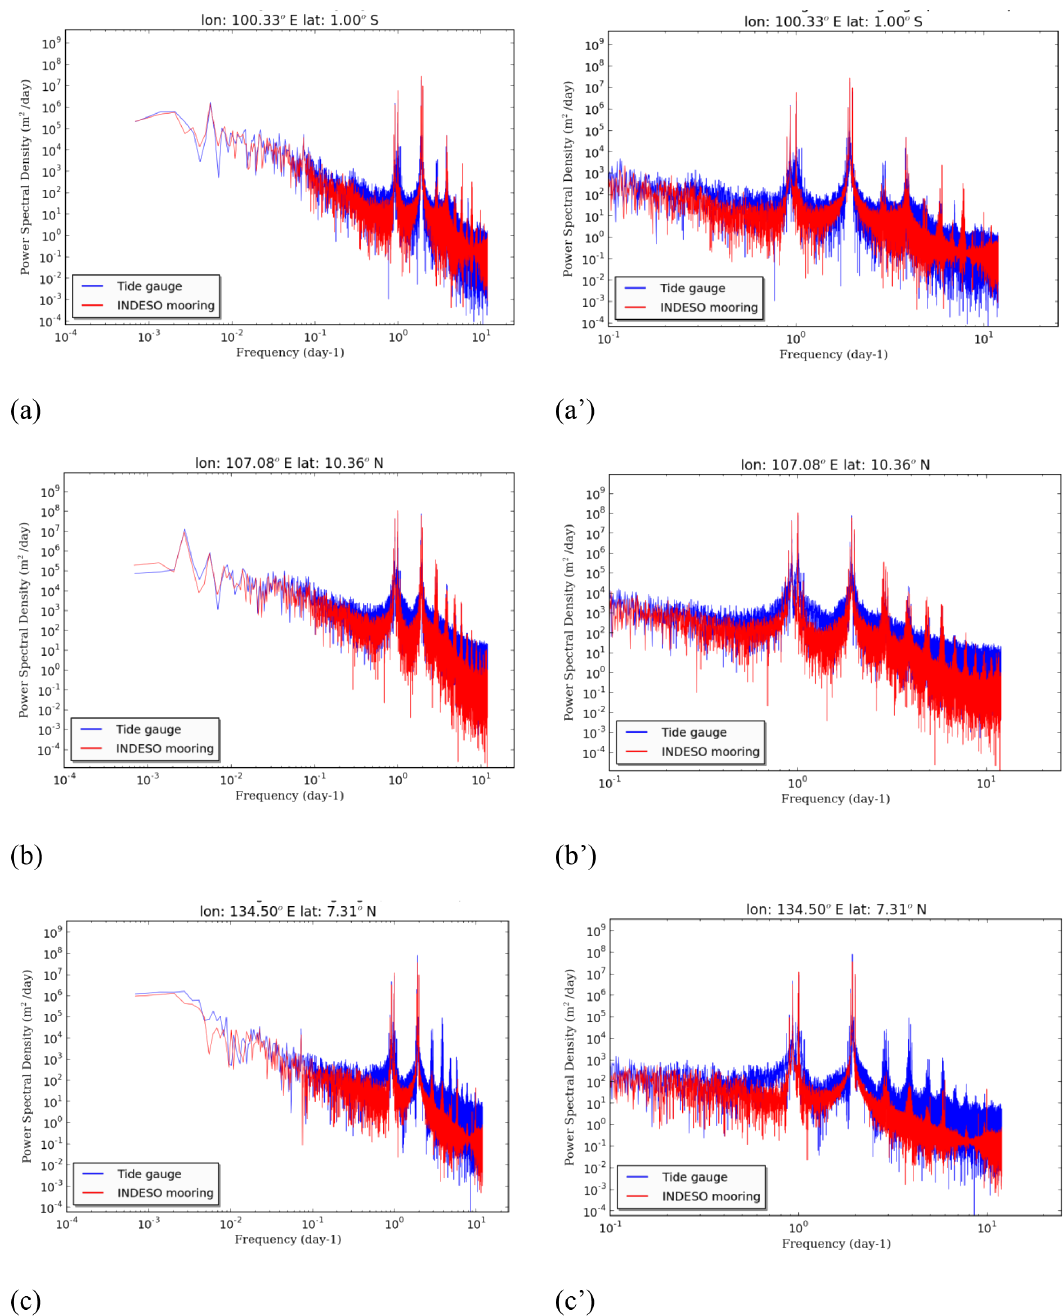
Figure 6. Power spectral density of the SSH for the model (red solid line) and for Tide gauges (blue solid line) at different locations ( (a) Padang (East Sumatra), (b) Vung Tau (SCS/South Vietnam) and (c) Malakal (Pacific)), calculated during 2009–2012 period. Right panel is a detailed view of the left